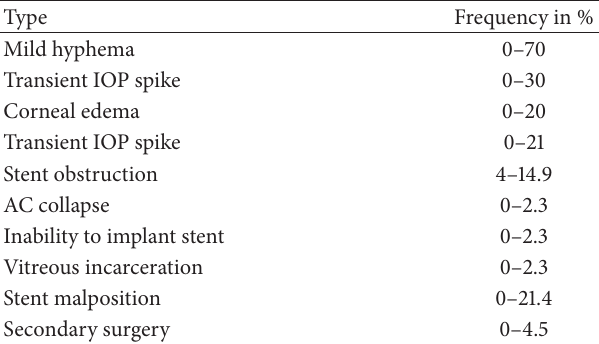
Table 6: Frequency of microbypass stent complications.